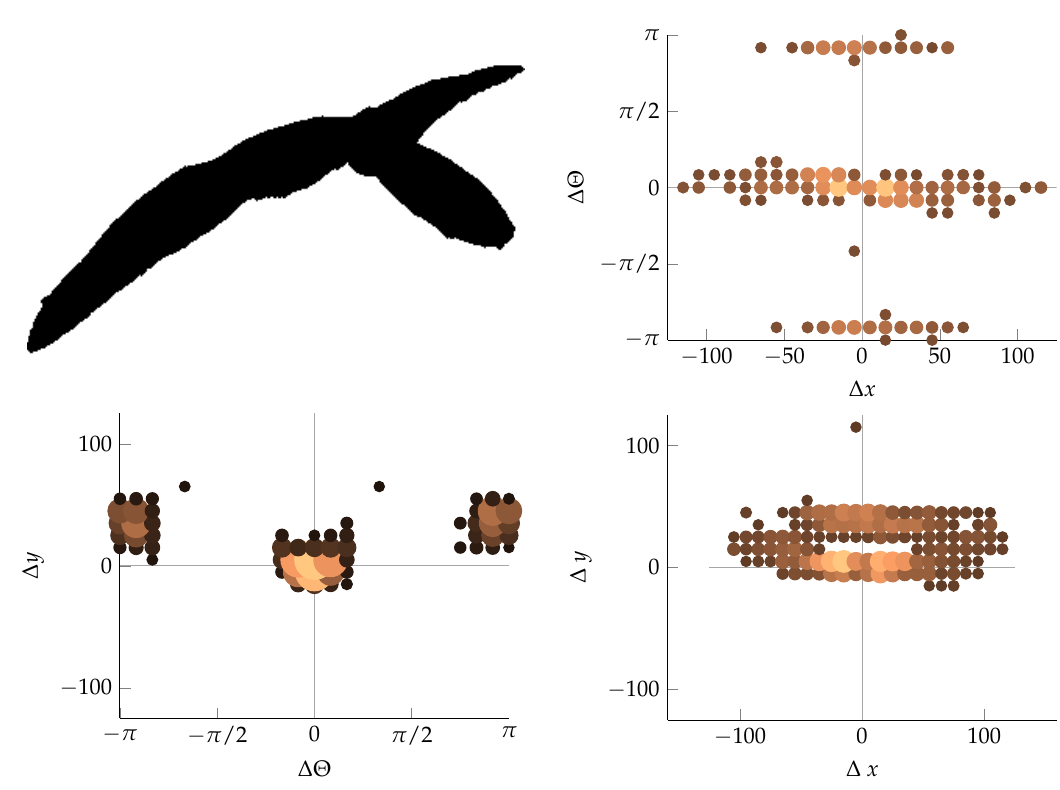
Figure 3. Monocots in 2D projection. The size and color of each dot denotes the number of occurrences of relative edge segments at the relevant position.